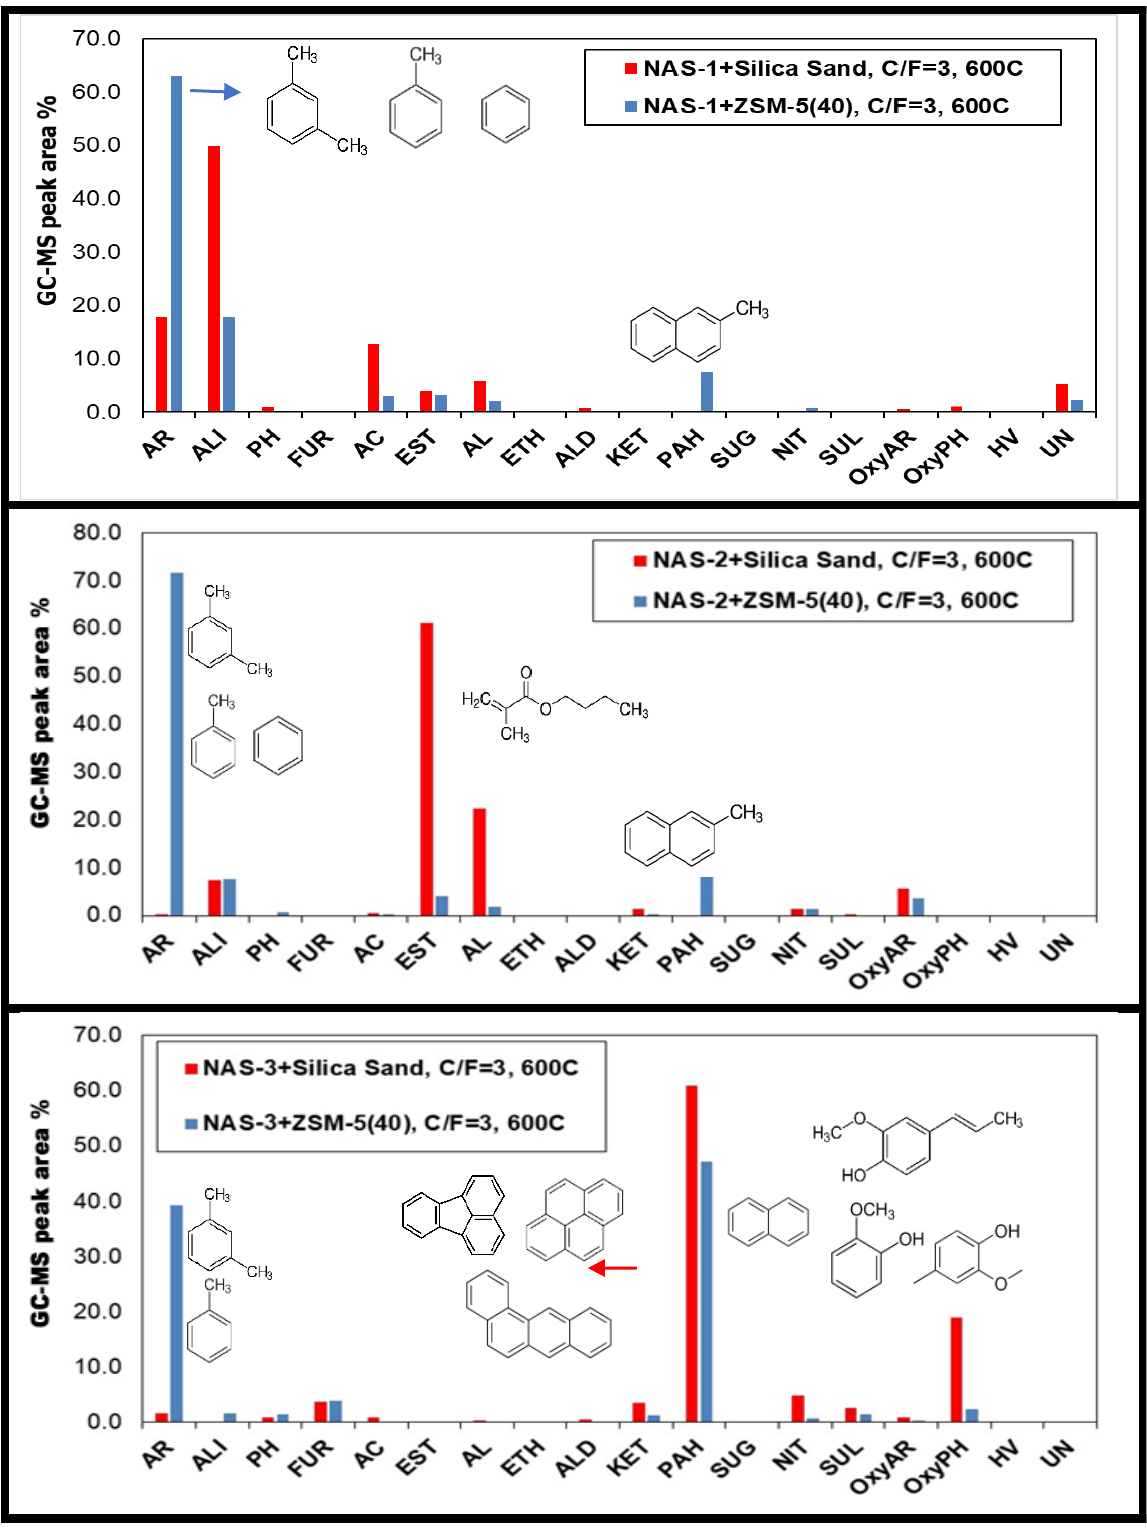
Figure 5. Relative concentration of the various groups of compounds in the fast pyrolysis vapors derived by the non-catalytic and catalytic fast pyrolysis (with ZSM-5 zeolite) of the three NAS samples at 600 °C, in Py/GC-MS system. Table 2. Composition of bio-oil derived from non-catalytic fast pyrolysis of residual paint (NAS-2)